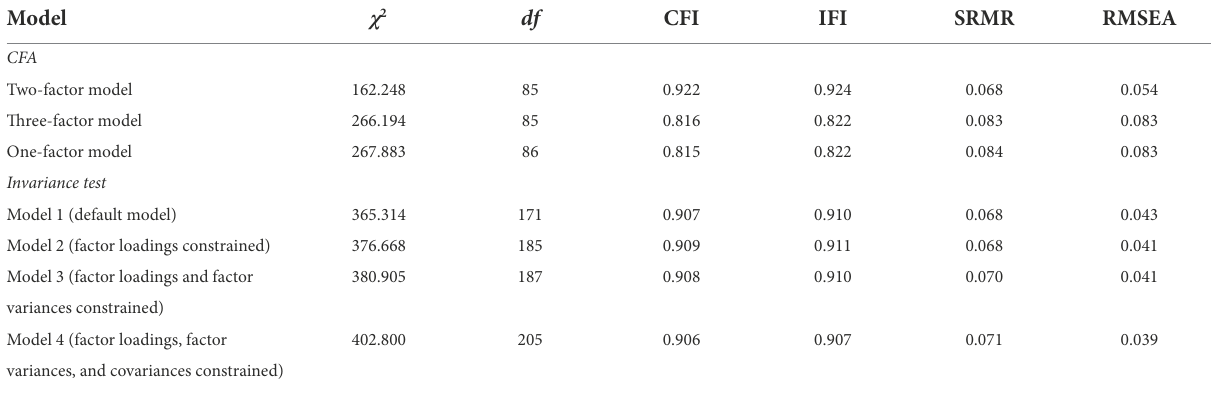
TABLE 2 Fit statistics for confirmatory factor analyses and invariance